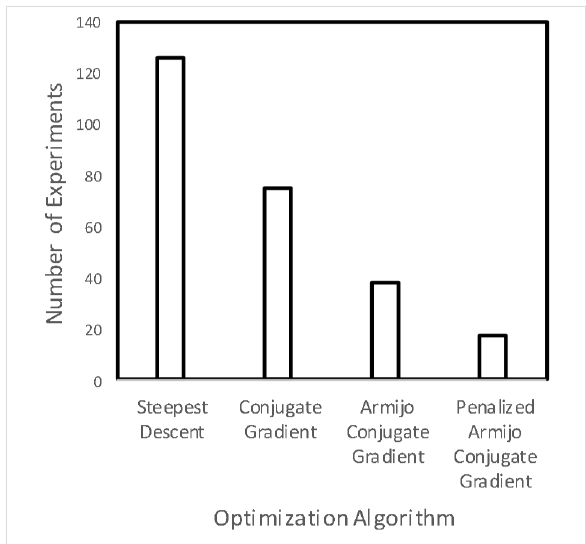
Figure 1: A number of experiments for various optimization algorithms